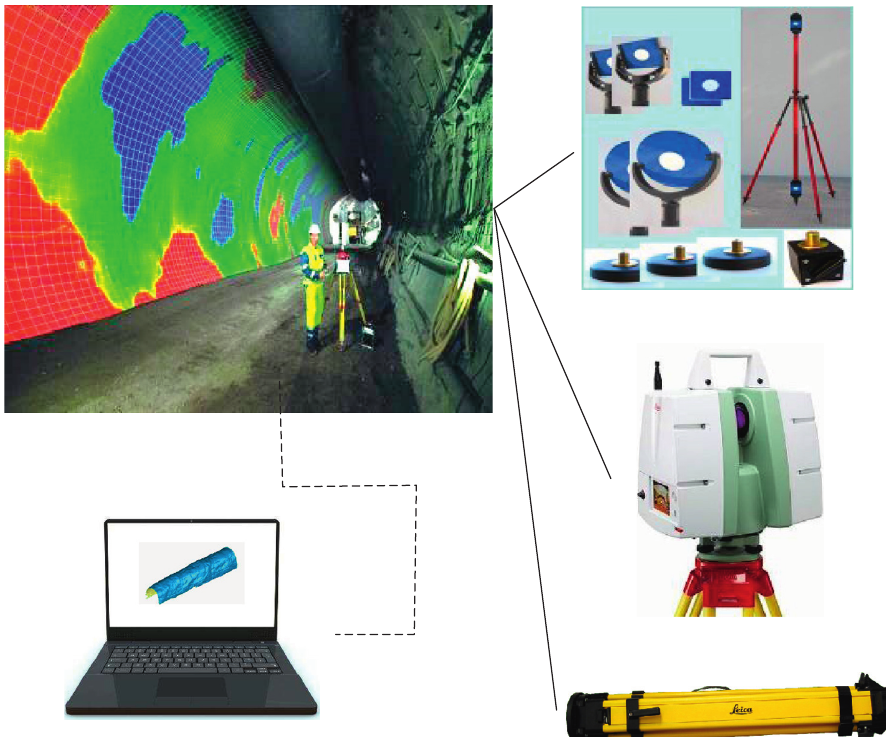
Figure 8: Operation of 3D laser scanning